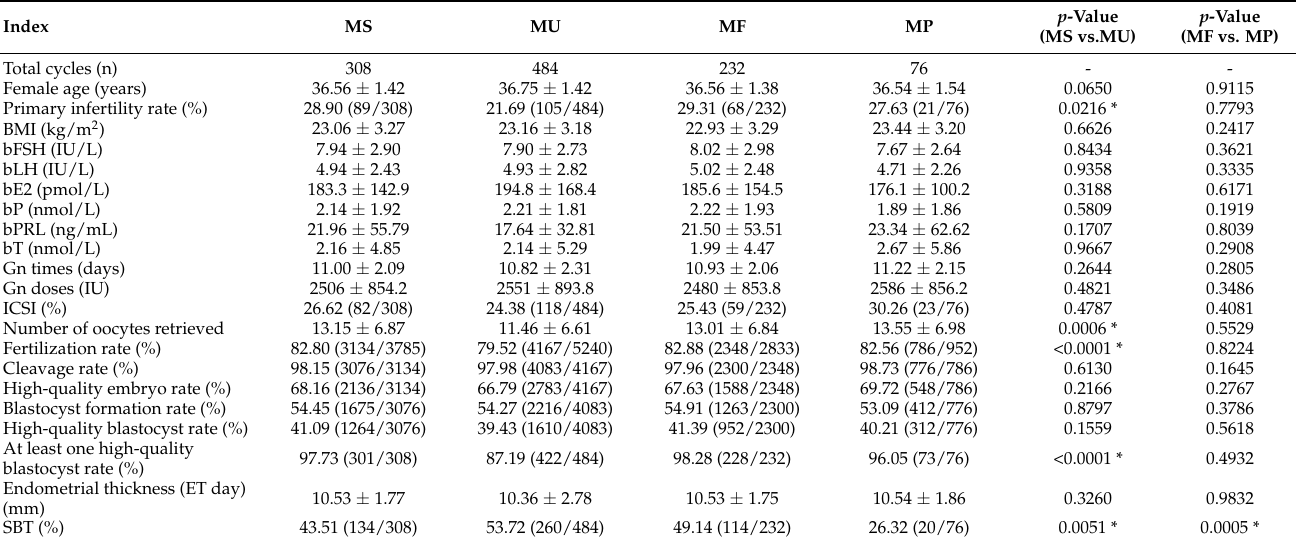
Table 3. Univariate analysis in the medium group (women aged between 35 and 39) with live birth or preterm birth as the dependent variable.